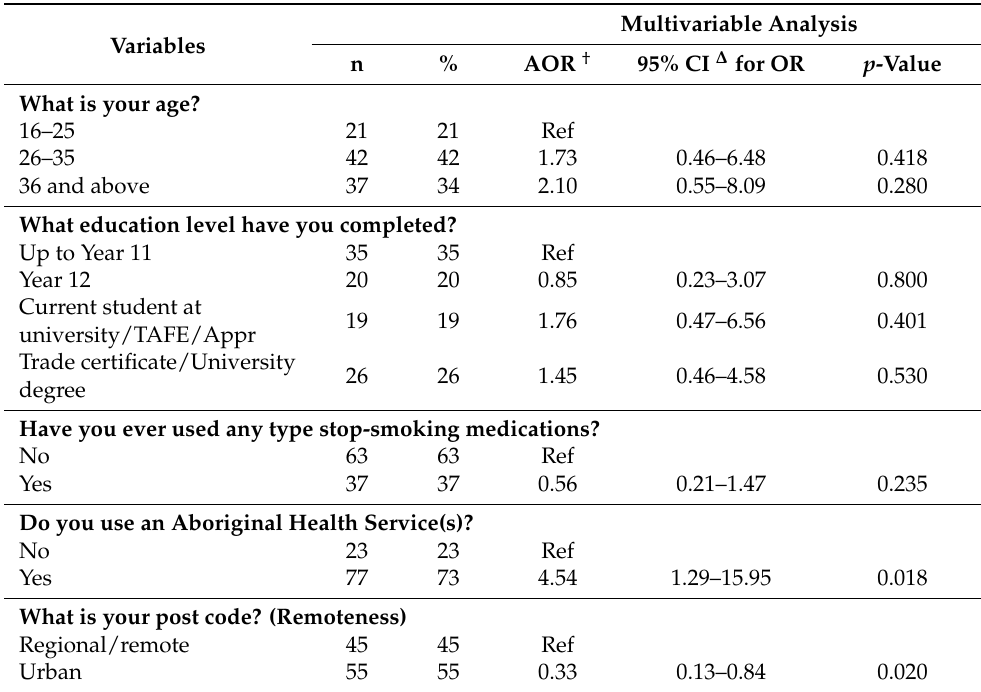
Table 3. Univariate and multivariable logistic regression for identifying factors associated with smoke-free pregnancy (N =